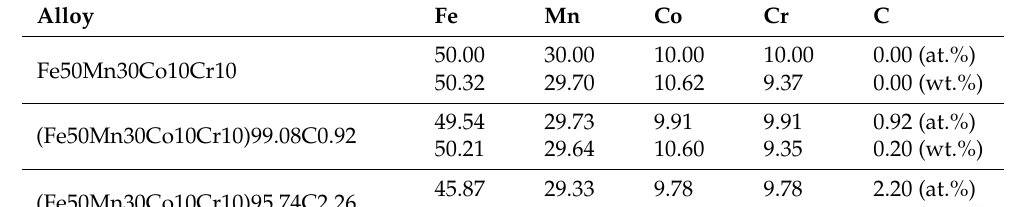
Table 1. Chemical compositions of the alloys.